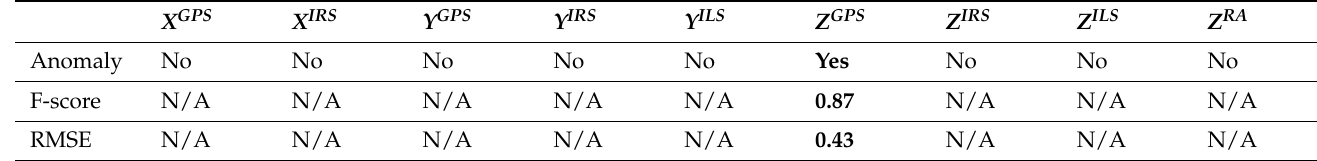
Table 4. Result for each signal after using NADCA.